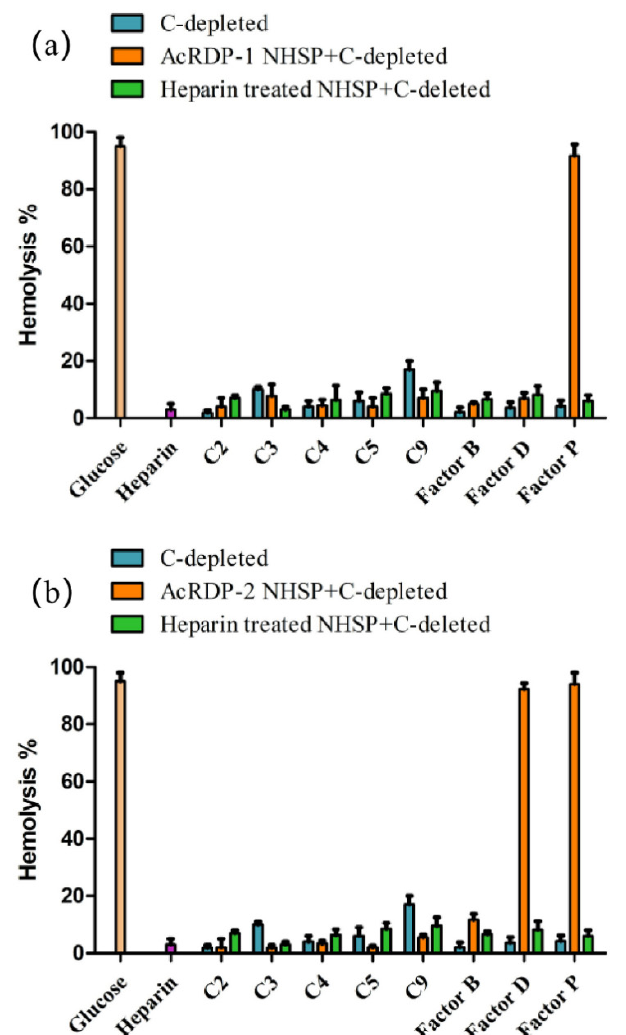
Figure 7. Targets of AcRDP-1 ( a ) and AcRDP-2 ( b ) in the complement activation cascade. On the whole, the anticomplementary activity of AcRDP-1 and AcRDP-2 was effec- tively increased by acetylation modification, which was associated with changes in the structural characteristics of AcRDP-1 and AcRDP-2. The activity of large molecular weight polysaccharides was susceptible to spatial hindrance [37], while the lower molecular weight acetylated polysaccharides may be more conducive to blocking complement components. Also, a large number of -OH groups were substituted by CH3-CO- groups in the polysaccha- rides with high DS. Huo et al. [18] stated that the presence of uronic acid in polysaccharides was considered important. However, unmodified polysaccharides (RDP-1 and RDP-2) do not have uronic acid, which may be one of the factors that cause the anticomplementary activity of RDP-1 and RDP-2 to be significantly weaker than that of heparin. With the introduction of acetyl groups, the triple helix conformation was de-rotated, and the